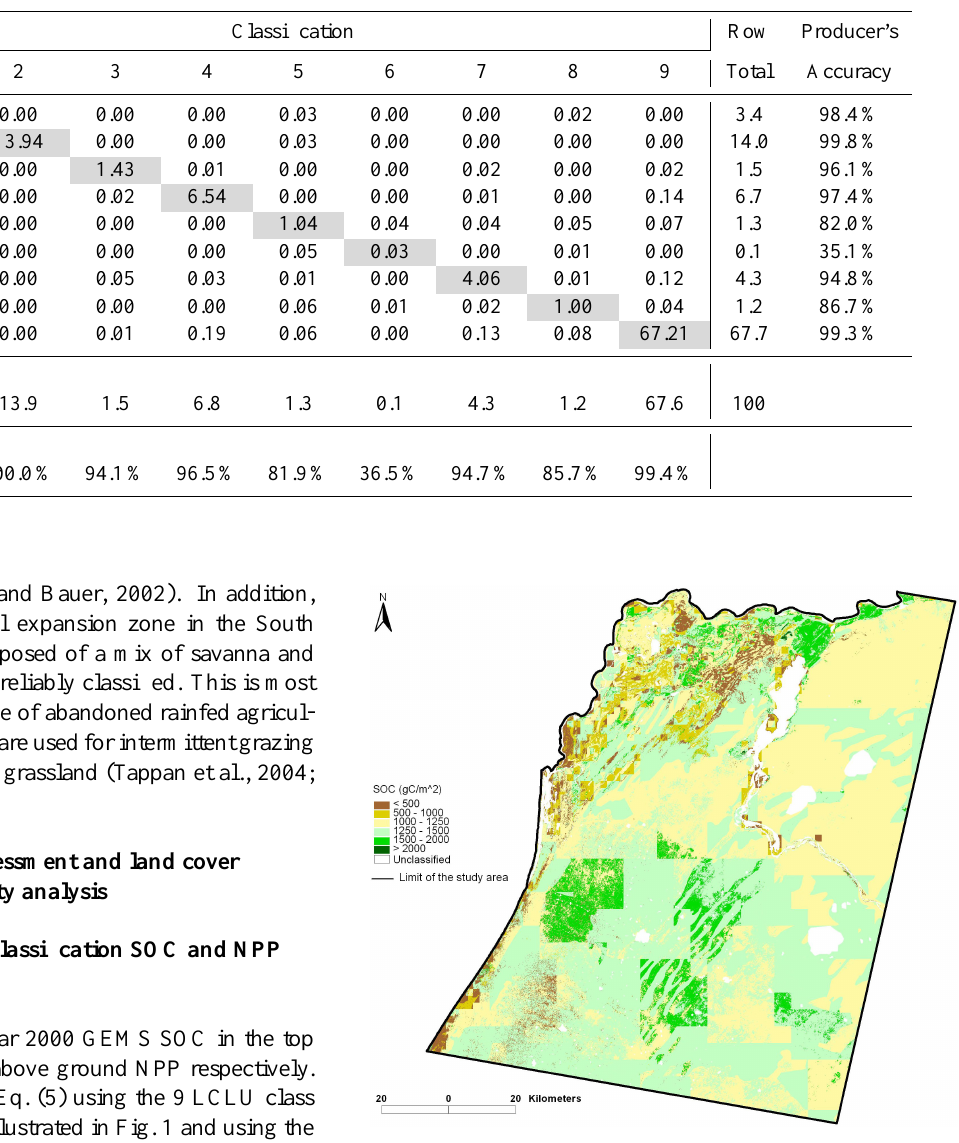
Table 3. Soft-to-hard confusion matrix results for the 9 land cover land use classes. The cell values report percentages of the total area; a total of 305 428 pixels were considered. The percent correct is 97.79% and Kappa-coefficient is 0.98. Grey fields, along the diagonal, represent for each class, the percentage correctly classified. The classes are: 1. Plantation; 2. Water; 3. Bare soil; 4. Rainfed agriculture; 5. Wetlands; 6. Mangrove; 7. Mud flats; 8. Irrigated agriculture; 9. Savanna grassland (Table 2).